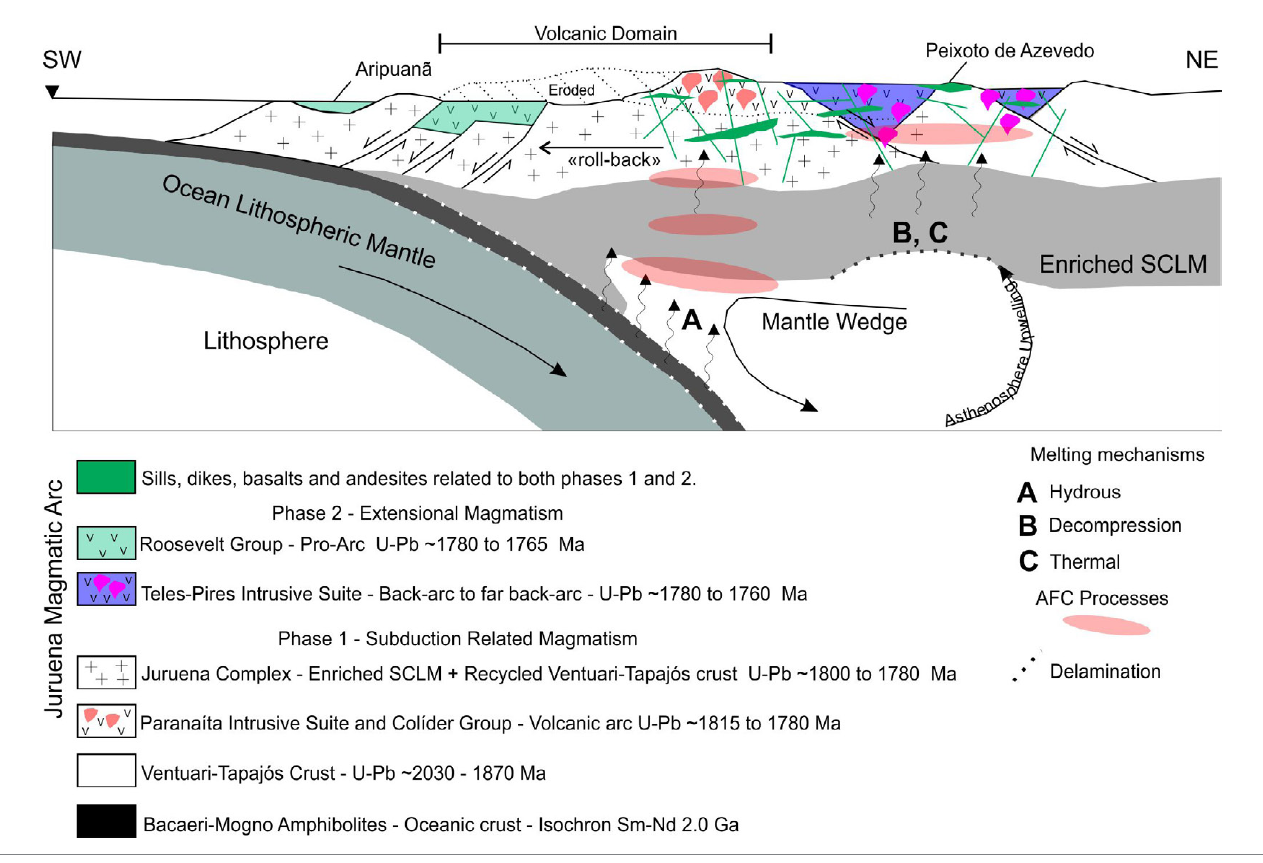
FIGURE 18 - Cross section scheme of tectonic evolution of the Juruena Magmatic Arc showing the arrangement of the discussed geological units within a proposal of magmatism in two phases related to subduction and extensional